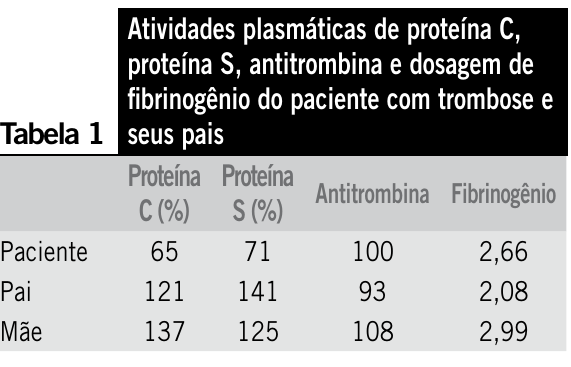
Figura 1 – Pesquisa do fator V de Leiden na criança e em seus pais. Raia 1: mãe; raia 2: pai; raia 3: paciente; raia 4: heterozigoto-controle; raia 5: não-digerido; raia 6: água Milli Q; eaia 7: marcador de peso molecular